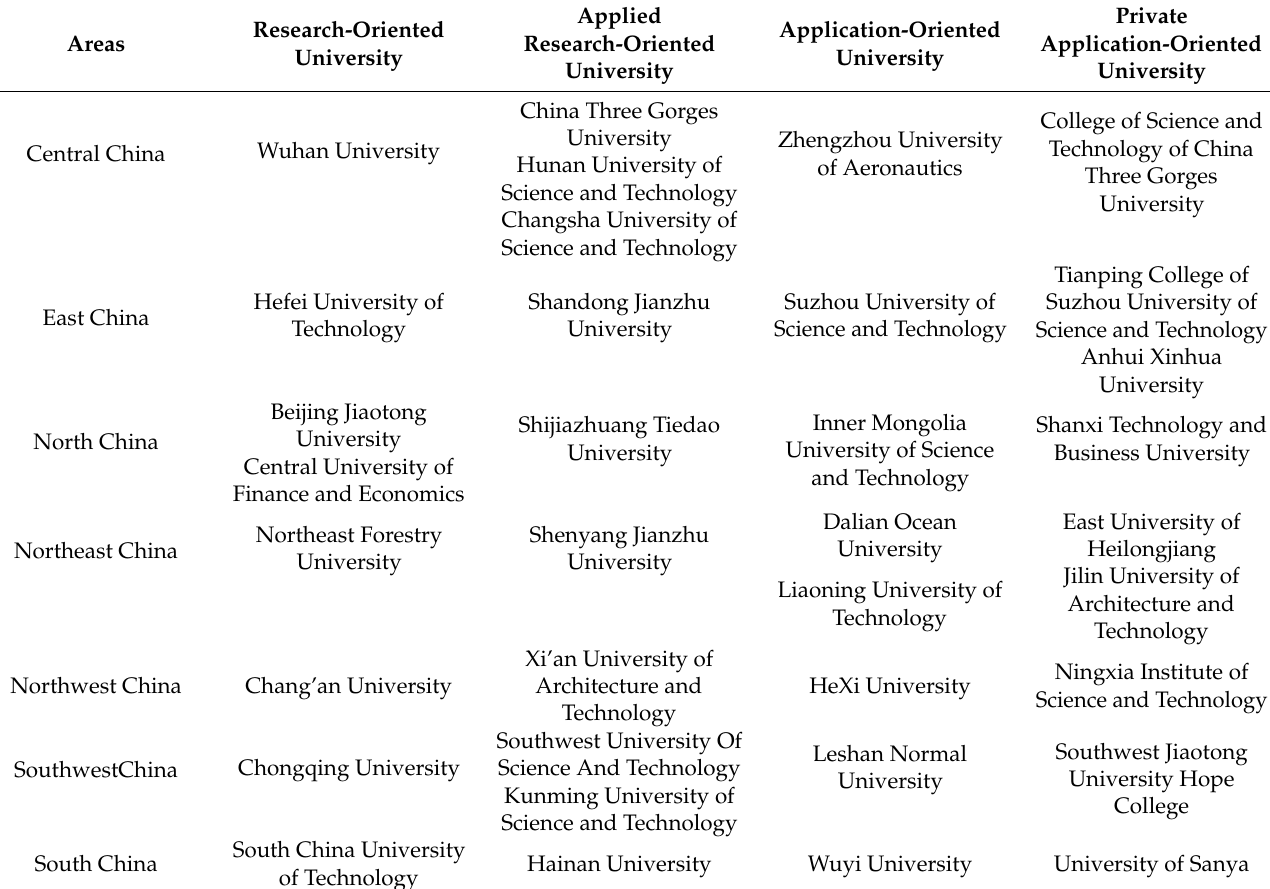
Table 2. Sample school selection